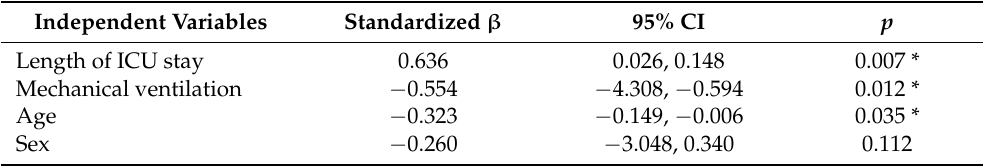
Table 2. Multiple linear regression analysis of clinical risk factors during admission of sarcopenia based on skeletal muscle index (SMI) in post-critical COVID-19